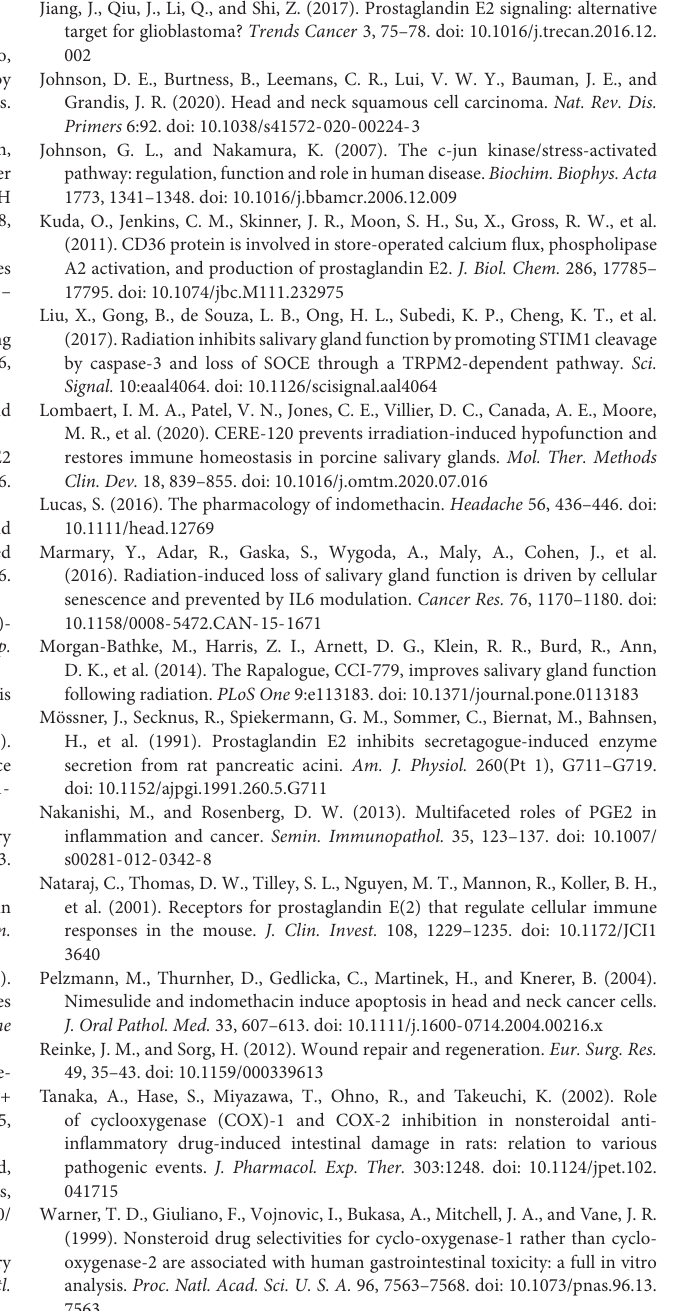
control. (A) Representative Western blot of changes in AQP5 and MIST1 levels following radiation and indomethacin treatments. (B,C) Densitometry was performed using ImageJ software and protein content was normalized to the average of the UT + Veh group ( ∗ p < 0.05; ns = not significant). Supplementary Figure 3 | EP1-4 receptors are present in murine parotid glands. Parotid glands were harvested from untreated (UT) C57BL/6J mice and used for immunoblots. The figure contains representative images of immunoblots for EPRs using antibodies against EP1R, EP2R, EP3R, and EP4R, which were stripped and re-probed for ERK1/2 as a loading